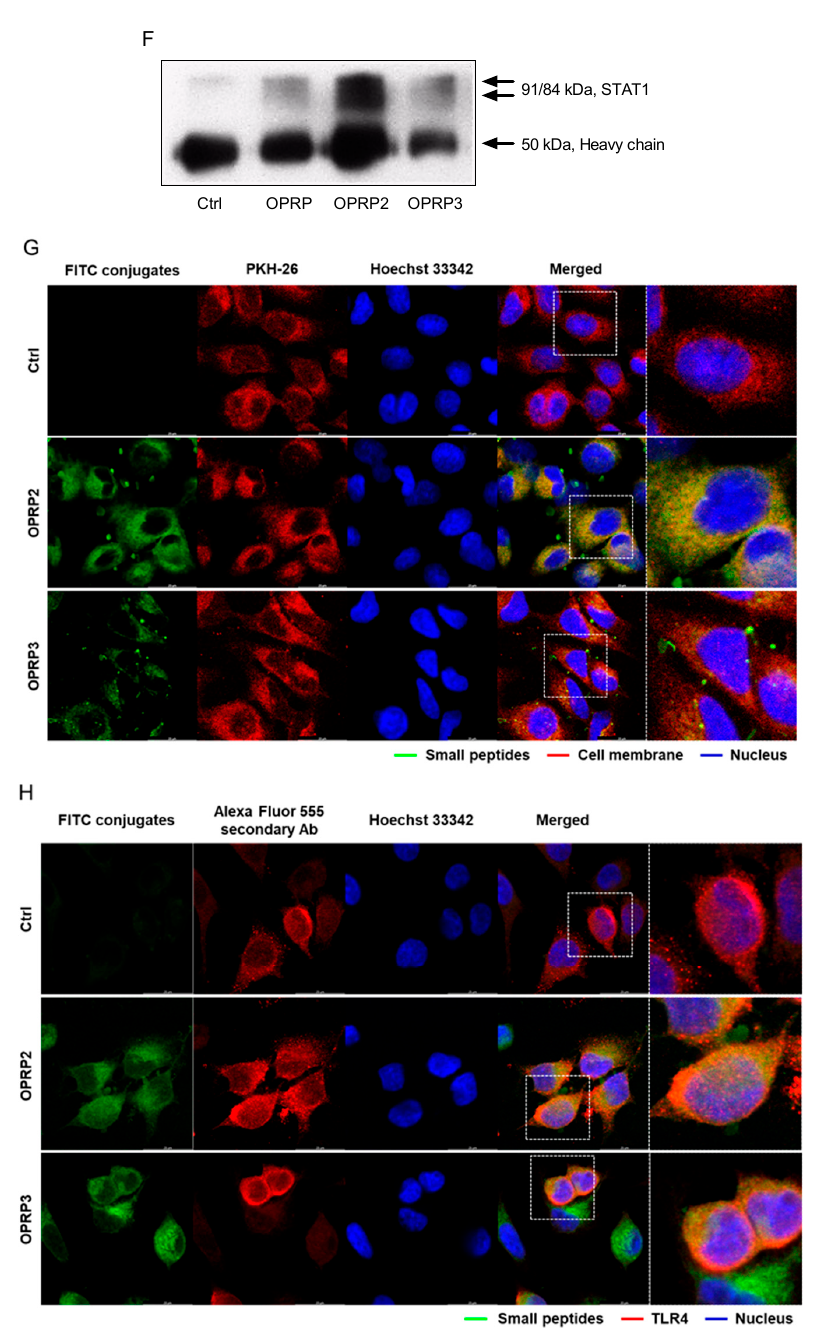
Figure 4. STAT1-STAT2 dimerization and type I IFN-dependent cell signaling of OPRP2 and OPRP3. ( A ) Small peptides were synthesized as described in Materials and Methods. ( B – D ) Expression levels of type I IFN-dependent antiviral genes (IFN- α , IFN- β , and Mx1) in Raw264.7 cells after treatment with OPRP2 or OPRP3. ( E , F ) STAT1 phosphorylation and IRF-9 expression were evaluated by Western blot analysis and STAT1-STAT2 dimerization was confirmed by co-IP analysis. ( G ) Interactions of OPRP2 and OPRP3 with cells were assessed by confocal fluorescence microscopy. FITC-conjugated OPRP2 and OPRP3 were captured and phospholipid (membrane) was compared by lipophilic PKH-26 staining. Hoechst 33,342 was used for counterstaining of nuclear staining. Scale bar, 20 μ m. ( H ) Interactions between TLR4 and OPRP2/OPRP3 were assessed by using TLR4 antibody stained with Alexa Fluor 555-conjugated secondary antibody (white box indicates a selected single cell to be magnified. Results are presented as means ± standard deviations from three separate experiments. * p < 0.05, ** p < 0.01, *** p < 0.001 vs. Ctrl.